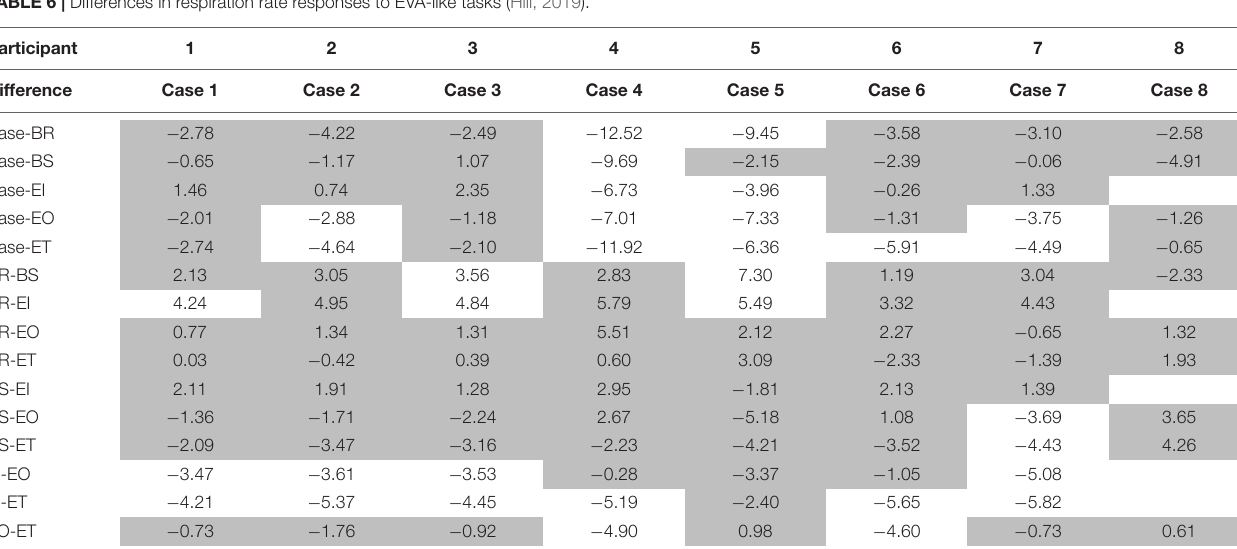
FIGURE 2 | Mean respiration rate responses to EVA-like tasks (Hill, 2019). TABLE 6 | Differences in respiration rate responses to EVA-like tasks (Hill,